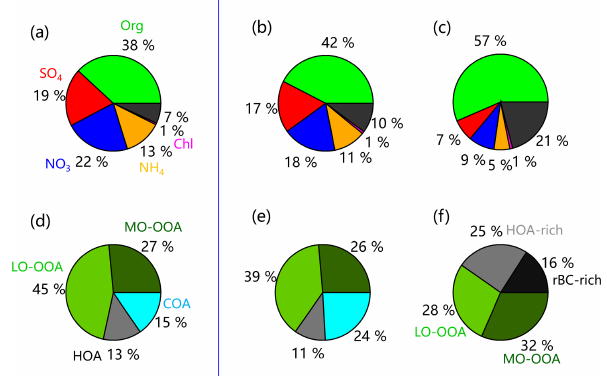
Figure 4. Average composition of PM 1 and OA in summer (a, d) 2018 and (b, e) 2017. The average composition of BC-containing aerosol and OA in summer 2017 is shown in (c, f)